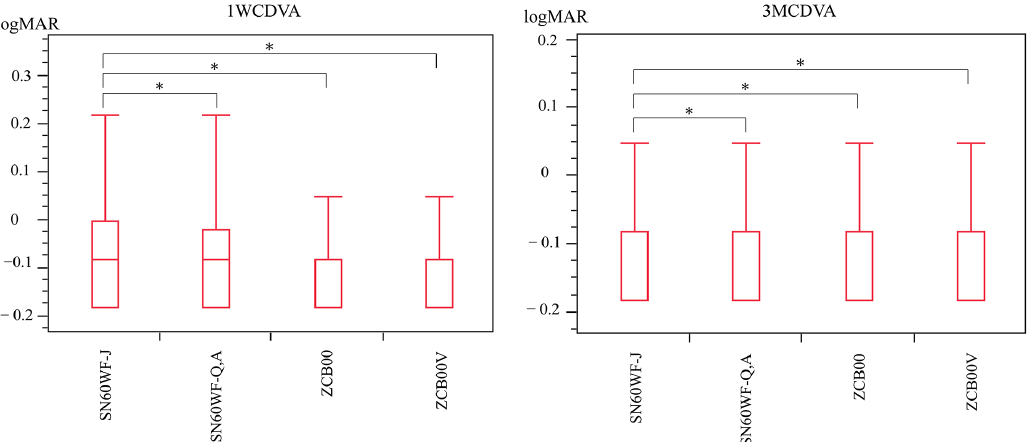
Figure 2. A comparison of corrected distance visual acuity 1 week postoperatively (1WCDVA, LogMAR) between the four groups shows that the SN60WF-J group had significantly higher and poorer visual acuity values than the other three groups did. Three months postoperatively (3MCDVA, LogMAR), the corrected distance visual acuity in the SN60WF-J group was significantly poorer than that of the other three groups. * Tukey–Kramer test, p < 0.05.